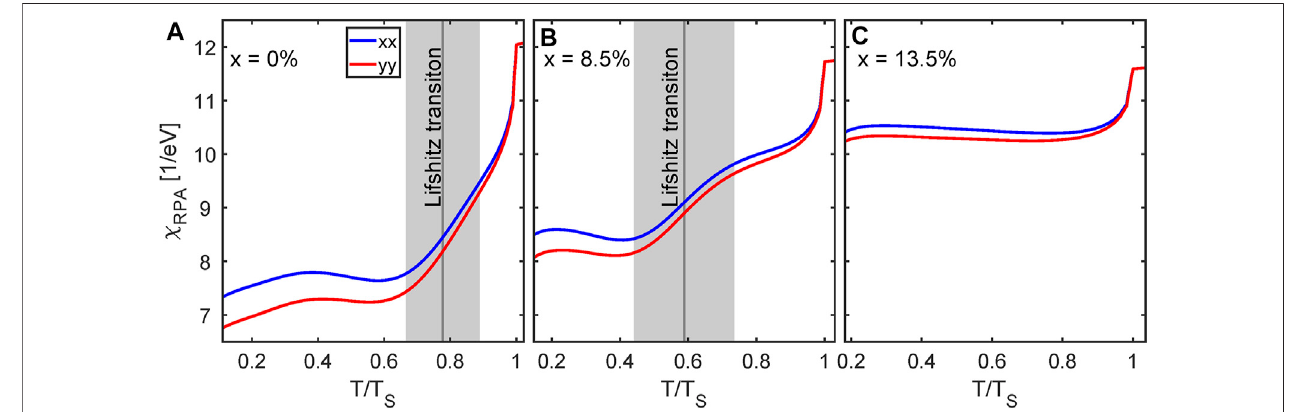
FIGURE3 | Calculated effect of sulphur dopingofFeSe 1 − x S x on temperaturedependence ofthe magnetic susceptibility χ ( q → 0). The panels (A) – (C) compare the doping values x = 0, x = 0.085 and x = 0.135. As in 2, the gray boxes illustrate the Lifshitz transition region of the Y -band. For x = 13.5, the Lifshitz transition is absent.